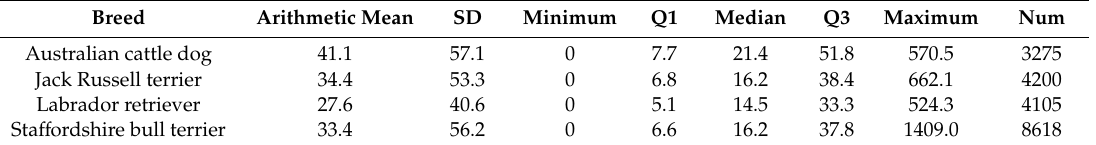
Table 4. Summary statistics of LOS for the four most common breeds ( n = 20,198 dogs).